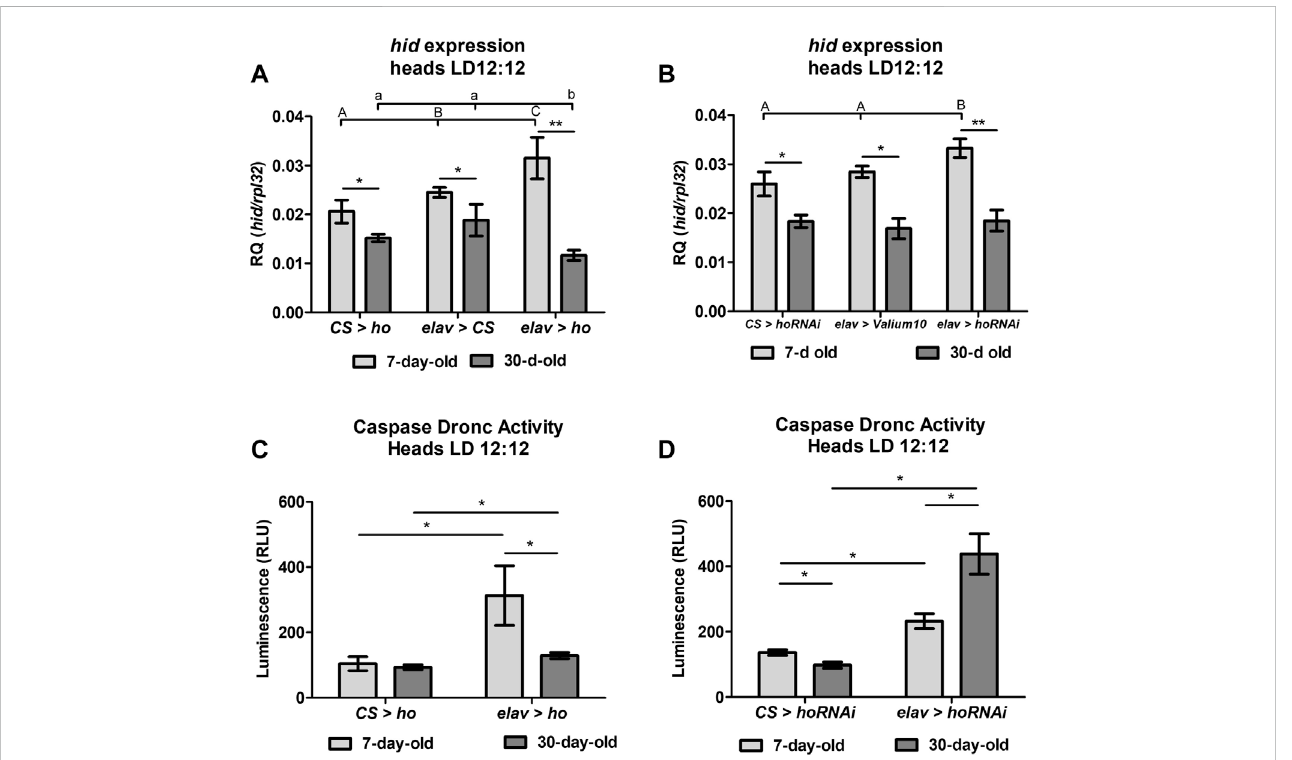
FIGURE 2 Aging affects the cell death activator head involution defective ( hid ) gene expression and the caspase Dronc activity in heads of fl ies with pan-neuronal ho overexpression or silencing. For hid expression (A,B) , means ± SD), statistically signi fi cant differences between genotypes are indicated with different letters (capital letters for 7-day-old and small letters for 30-day-old fl ies; non-parametric ANOVA Kruskal – Wallis and post hoc Conover-Iman tests: ho overexpression in 7-day-old p = 0.008, 30-day-old p = 0.006; ho silencing in 7-day-old p = 0.008, 30-day-old p = 0.6) and between different age groupsby asterisks (7-day-oldvs.30-day-oldineachgenotype;non-parametricMann-Whitneytest: elav > hop =0.008;CS > hop =0.03; elav > CS p =0.02; elav > hoRNAi p = 0.004; CS > hoRNAi p = 0.04; elav > Valium10 p = 0.04). For caspase Dronc activity (C,D) , means ± SEM), statistically signi fi cant differences between genotypes and between age are indicated with asterisks (non-parametric Mann-Whitney test: ho overexpression in 7-day-old p = 0.03, 30-day-old p = 0.05; ho silencing in 7-day-old p = 0.03, 30-day-old p = 0.03; 7-day-old vs. 30-day-old in each genotype through non-parametric Mann-Whitney